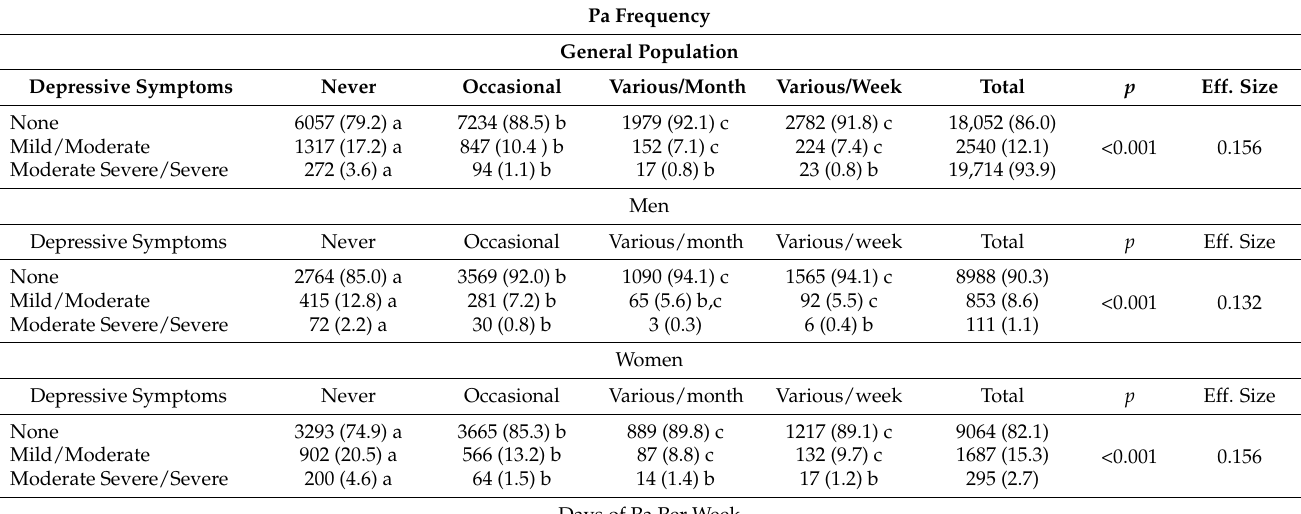
Figure 1. PA frequency and prevalence of depressive symptoms in the general population. Table 2. Relationship between frequency of PA, days of activity and muscle strengthening per week and depressive symptoms.